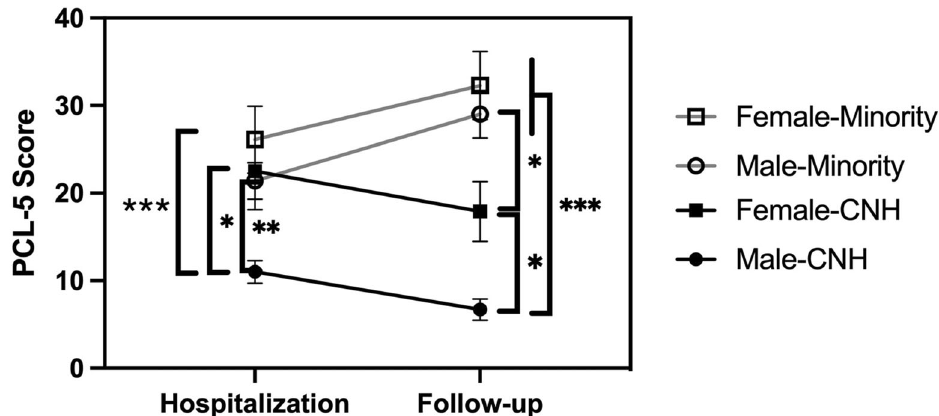
Fig. 1 Total PCL5 scores were measured at hospitalization and follow-up, which occurred 6 – 8 months after discharge. The total cohort of 170 individuals was divided into subgroups based upon self-reported race, ethnicity, and sex. The minority subgroup included individuals endorsing African American, Black, Hispanic, and Native American. The number in each group is Caucasian, non-Hispanic (CNH) men (57); CNH women (23); minority men (61), and minority women (29). Symbols represent the mean; vertical lines represent the SEM. * p < 0.05; ** p < 0.005, and *** p < 0.001 by Tukey ’ s HSD test.